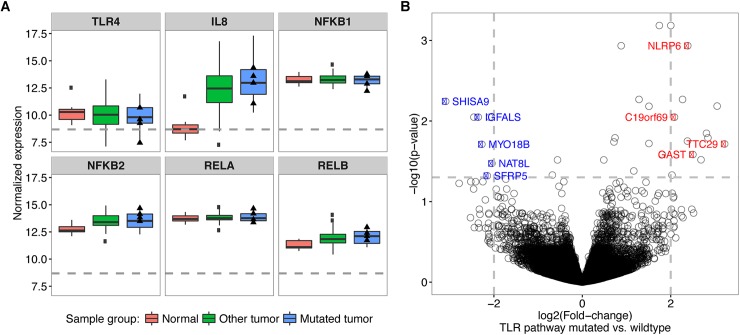
Gene expression in EAC tumors with TLR pathway mutations.(A) RNA-Seq data for TLR4, IL-8 and NF-κB genes in the TCGA cohort. The 89 EAC samples were split into TLR pathway mutated (n = 17) and wild-type samples (n = 72) using the matched mutation data. The y-axis shows the gene expression data normalized by the library size with the median by sample group indicated as a solid black line within each box. The lower edge and the upper edge of the boxes represent the first and the third quartile of the expression value distribution, respectively. The lower whisker represents the lowest value within 1.5-times the inter-quartile range from the lower edge of the box and the upper whisker the highest value accordingly. Dots indicate outliers to these ranges and triangles indicate the expression values of samples with a TLR4 mutation. The horizontal dashed grey line indicates the average expression value of all genes. (B) Vulcano plot showing the–log10-transformed, adjusted p-values from the differential expression test on the y-axis and the estimated log2-transformed fold-change between TLR mutated vs. wild-type samples on the x-axis. The grey dashed lines show the fold-change and p-value cutoffs applied to detect significantly differentially expressed genes. The colored and labeled points indicate down-regulated (blue) and upregulated (red) genes in TLR pathway mutated samples as compared to the wild-type and to the normal samples.